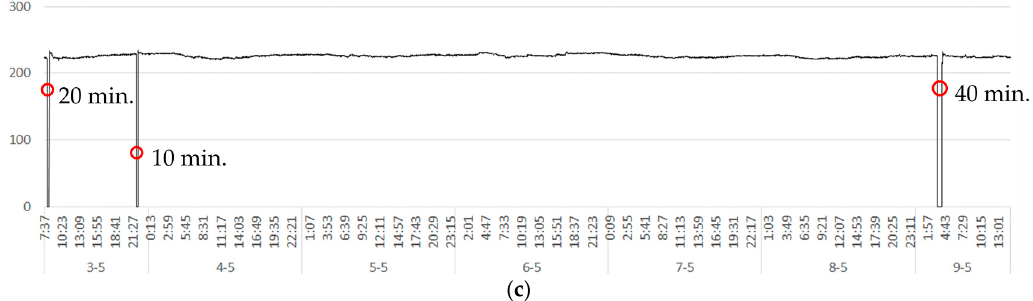
Figure 9. Blackout events during the measurement period in ( a ) Pekanbaru, ( b ) Kupang, and ( c ) Jayapura. Note the different time scales between the measurement locations. Red circles indicate blackout events and its duration in minutes.